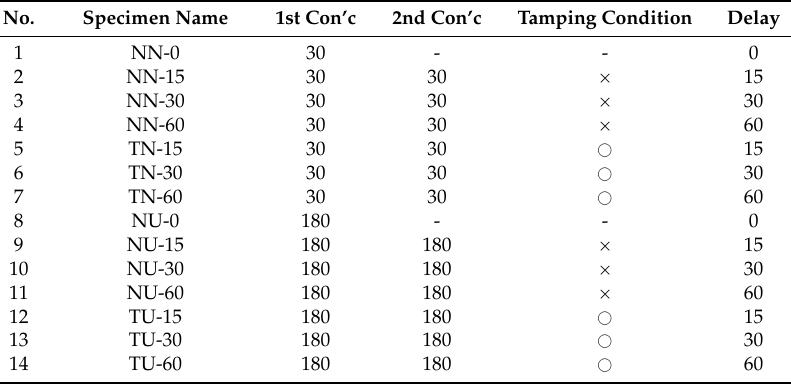
Figure 1. Overview of specimen nomenclature.